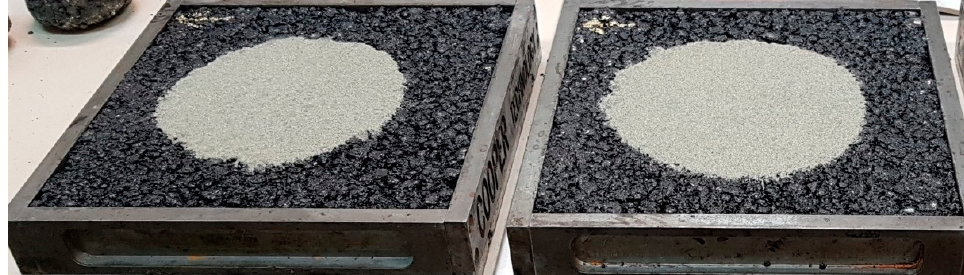
Figure 9. Surface macrotexture characterization.